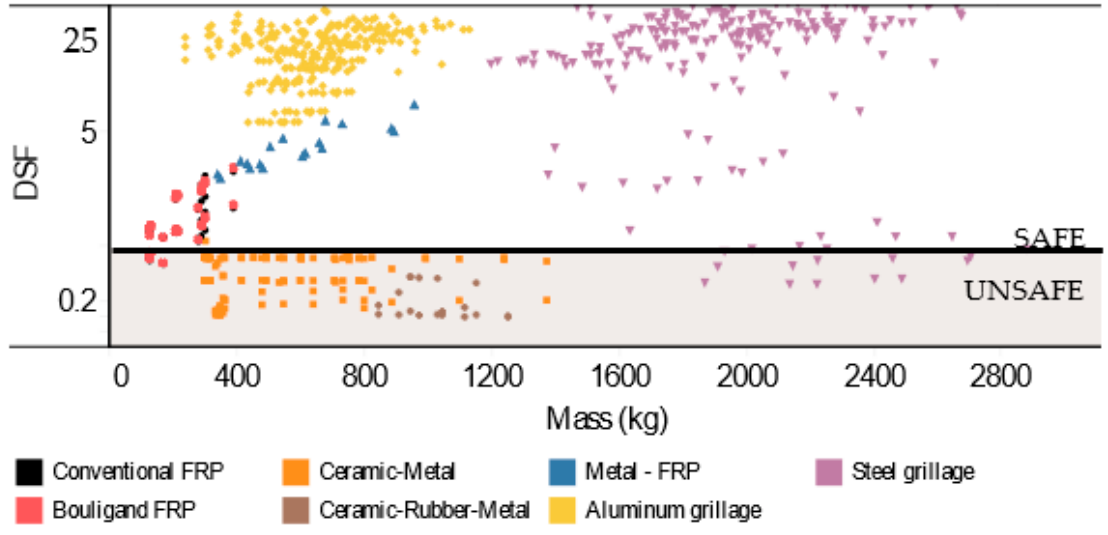
Figure 8. Comparison of structural concepts for deformation safety factor with mass.